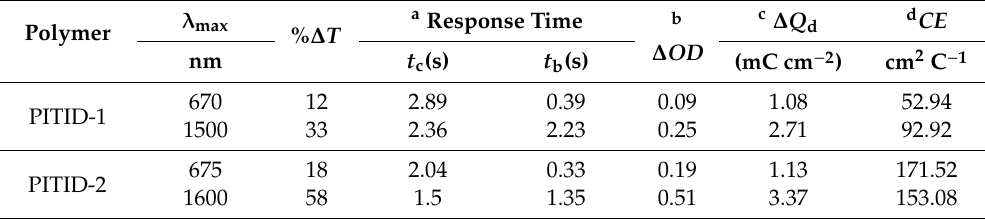
Figure 8. Square-wave potential step for PITID-1 ( a1 , a2 ) and PITID-2 ( b1 , b2 ) in a 0.2 M TBAPF 6 /ACN solution, by applying the potential from 0 to 1.35 V. ( a1 ) 670 nm, ( a2 ) 1500 nm, ( b1 ) 670 nm, and ( b2 ) 1600 nm. Switching time: 10 s step, 4 s step, 2 s step, 1s step, and back to 10 s, and 150 s for per step. Table 3. Electrochromic performance of PITID-1 and PITID-2 polymer films. Table 3. Electrochromic performance of PITID-1 and PITID-2 polymer